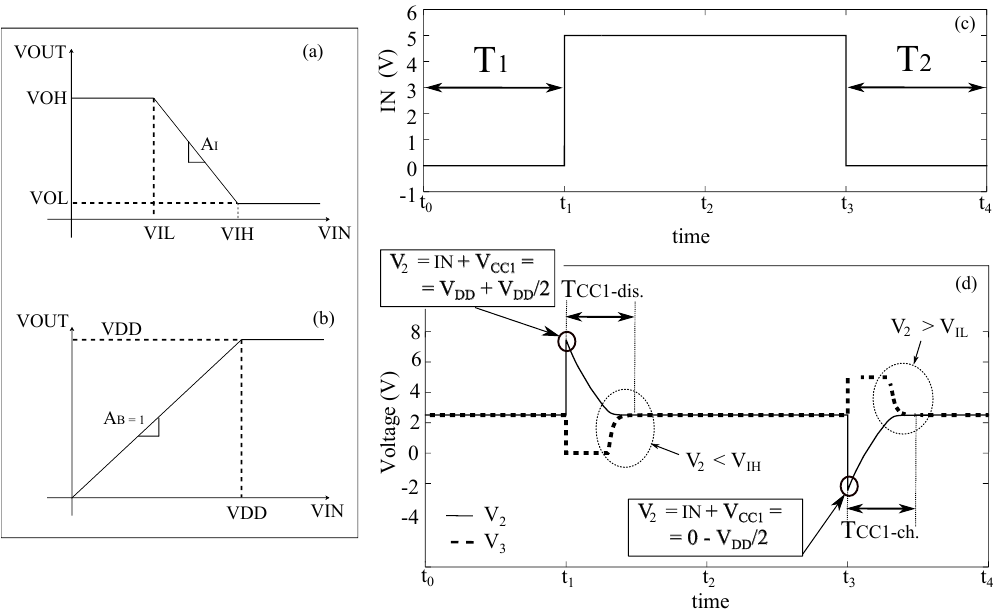
Figure 10. Bidirectional amplifier with piecewise linear model of the PFGA in actuation mode. ( a ) piece-wise linear model of the inverter; ( b ) piece-wise linear model of the voltage buffer; ( c ) input pulse applied during actuation mode. T1 is the time interval ([ t 0 , t 1 ]) between the transition Φ : 0 → 1 and the rising edge of the input pulse, T2 time interval ([ t 3 , t 4 ]) between the falling edge of the input pulse and the transition Φ : 1 → 0; ( d ) input and output of the bidirectional amplifier during actuation mode. T CC1-dis ,T CC1-ch discharge and charge time of capacitor C C1 ,respectively.